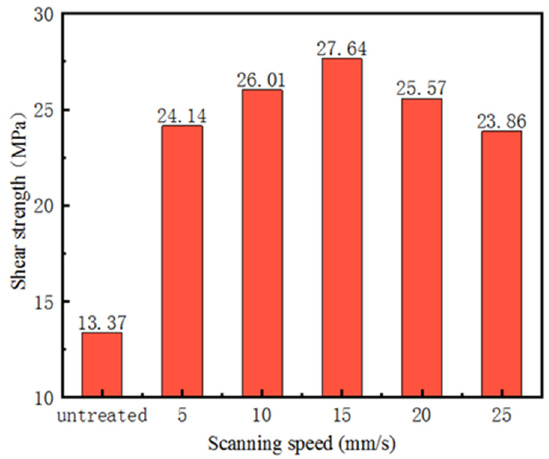
Figure 7. Shear strength values of the samples.